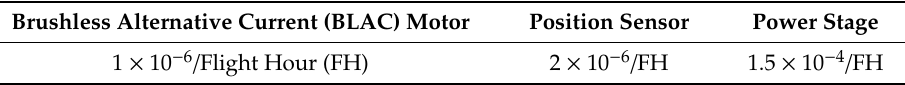
Table 1. Failure occurrence rate of one actuating